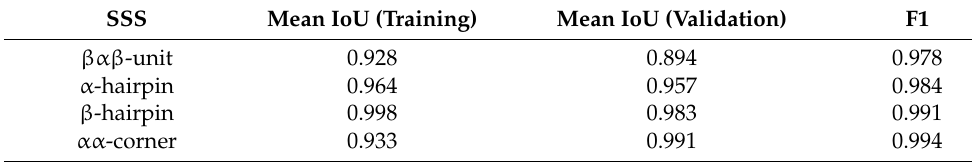
Table 4. Performance metrics: IoU and